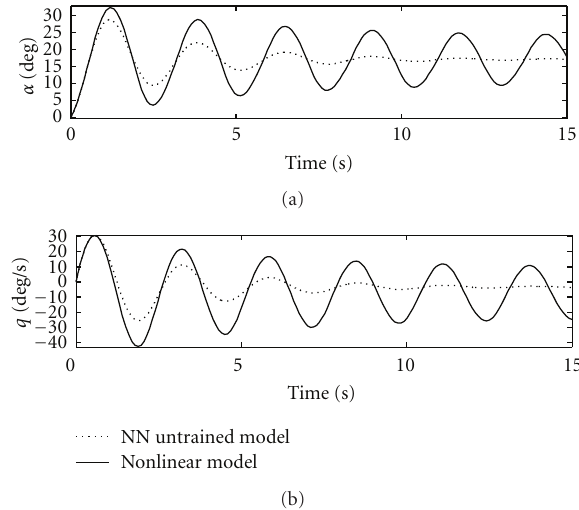
Figure 6: NN trained model versus nonlinear models for fighter dynamics.